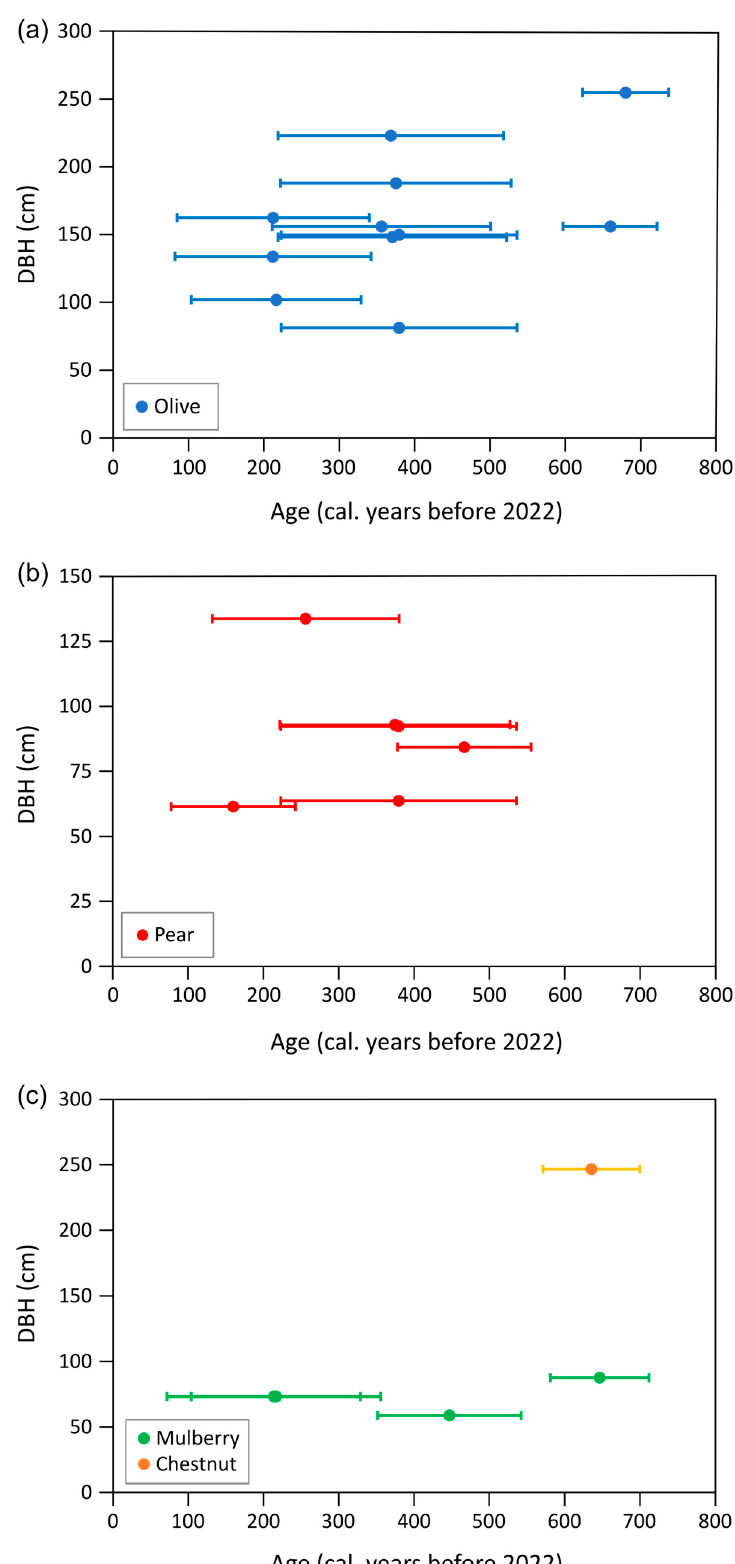
Figure 6. Radiocarbon analysis results for ( a ) Olive trees, ( b ) Pear trees and ( c ) Mulberry and Chestnut trees. Raw radiocarbon dates were calibrated (see Section 2) and ages were calculated from the sampling year (2022). Confidence intervals (2 sigma) of calibrated radiocarbon dates are shown as horizontal bars.